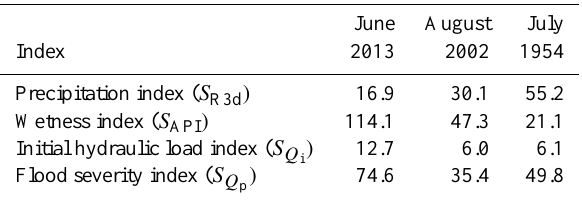
Table 2. Severity indices for June 2013, August 2002 and July 1954